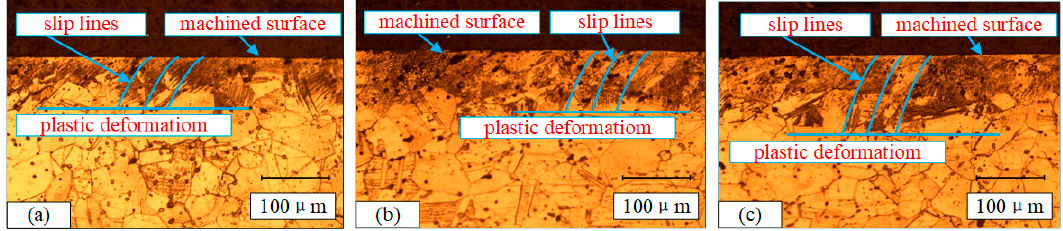
Figure 12. Microstructure micrograph close to the surface layer at di ff erent feed rates: ( a ) sample 7; ( b ) sample 8; ( c ) sample 9.